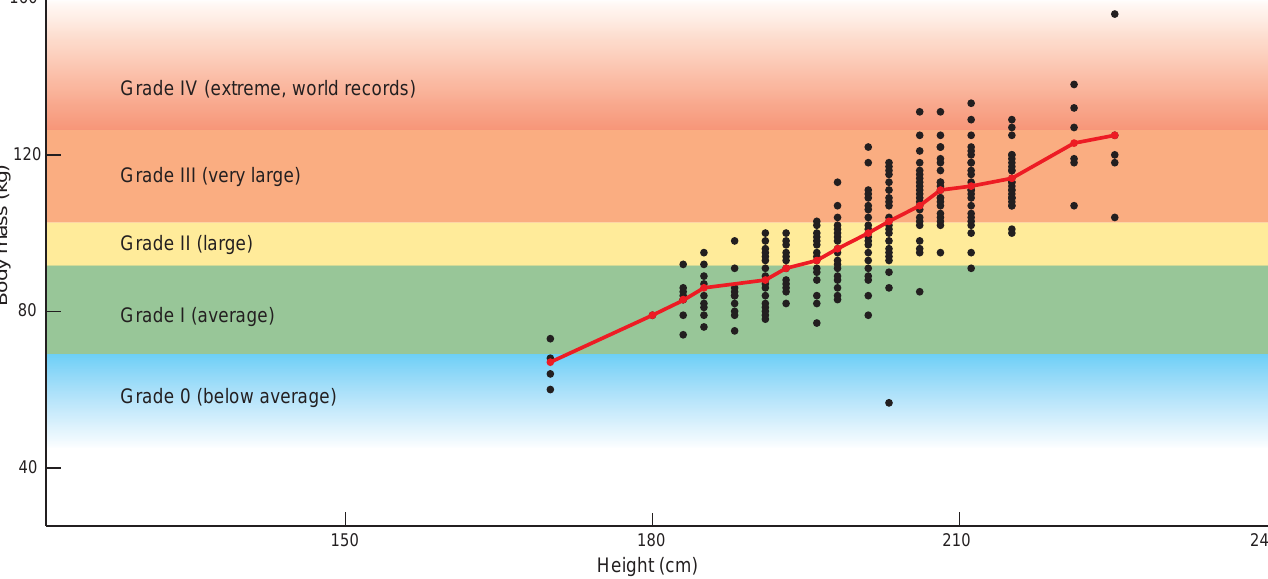
Fig. 9. Plot of height vs. weight for 561 male Homo sapiens in optimal conditions from 170 cm (low average) to 225 cm tall. Average growth curve (red